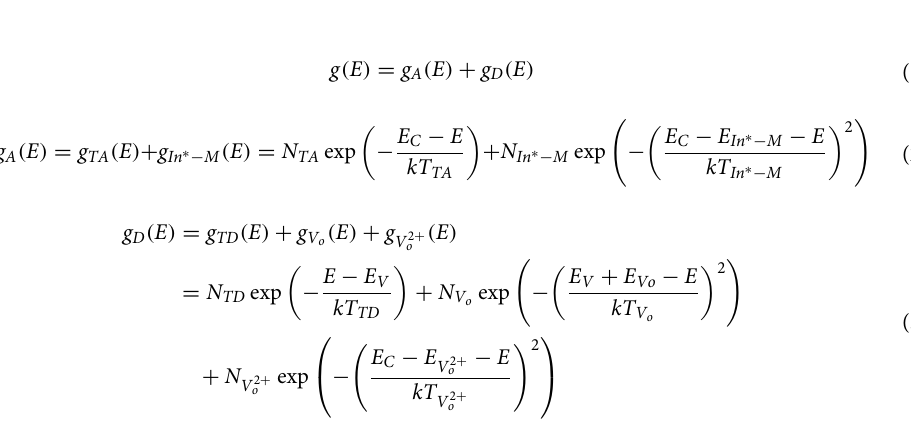
Figure 3. ( a ) The DOS depending on the O content, extracted from the BG IGZO FETs with W / L = 1/ 20.2 μm. The inset shows the measured photo-response of the I–V curve. ( b ) The extracted DOS (symbol) fitted with the proposed DOS model